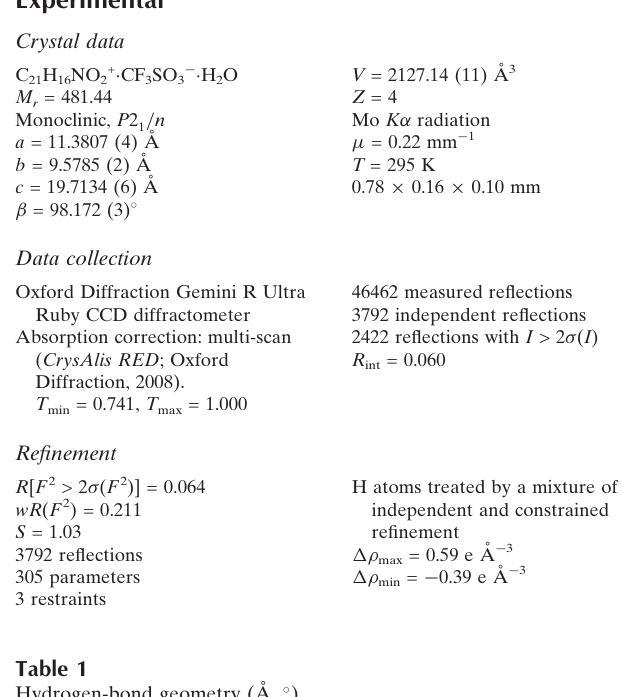
Hydrogen-bond geometry (A˚ , (cid:4) ). Cg 4 is the centroid of the C18–C23 ring.